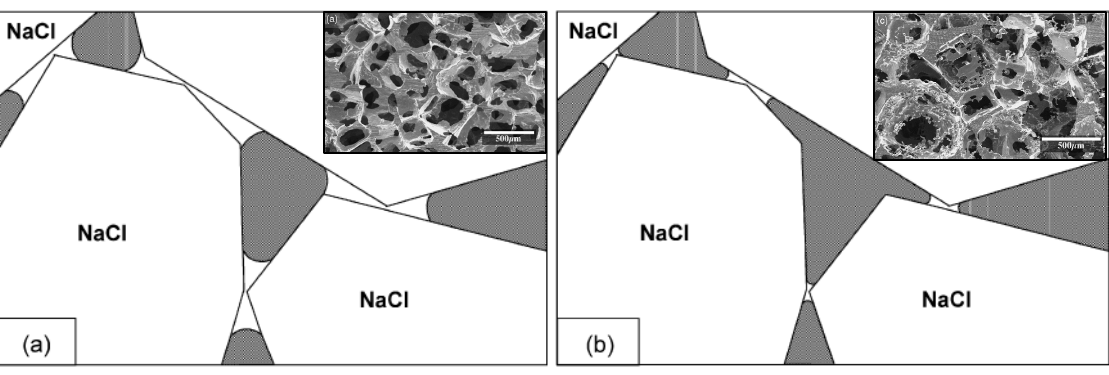
Figure 1. Schematic of the effect of infiltration pressure on Al flow into the channels between NaCl particles and SEM micrographs of the resulting structures (inset): ( a ) at low pressure, 0.2 MPa; and ( b ) at high pressure, 1 MPa, modified from [7].